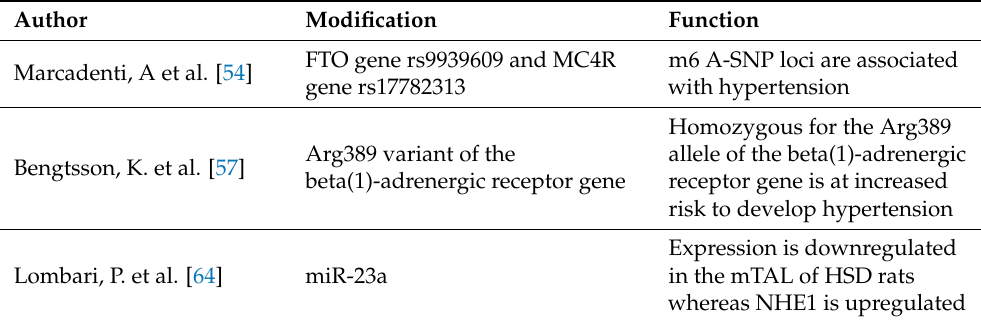
Table 1. Features of main studies evaluating the link between mRNA metabolism and hypertension. Arntl: aryl hydrocarbon receptor nuclear translocator such as FLNA: filamin A, FLNB: filamin B, FTO: fat mass and obesity associated gene, HSD rats: high sodium intake induced hypertensive rats,